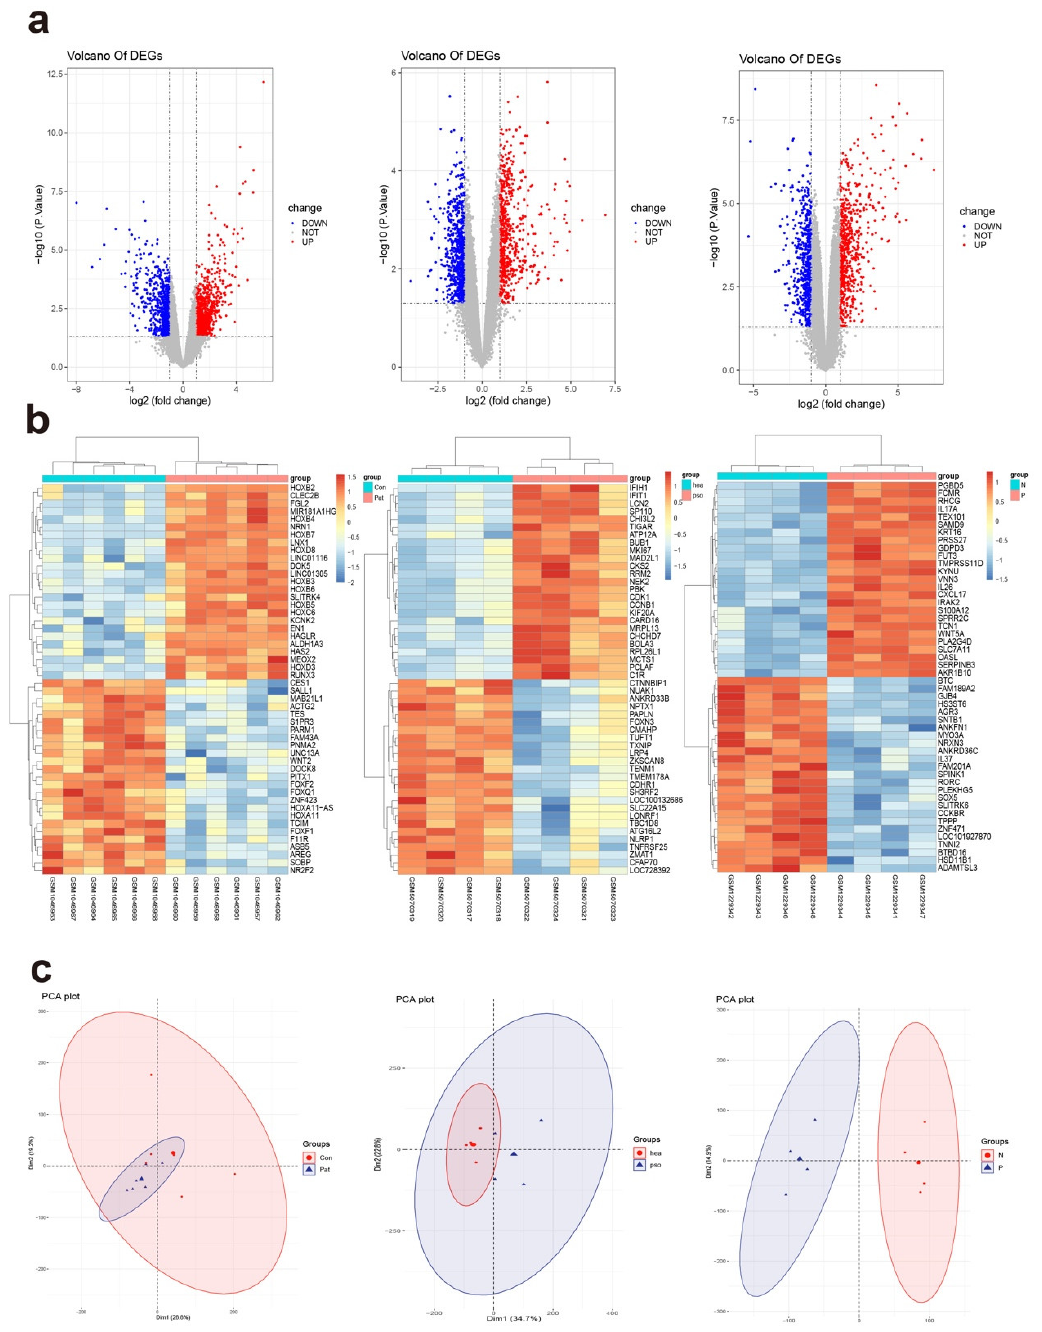
Figure 1. ( a ) Volcano plot representing DEGs among normal control group, PN and PP. The X -axis indicates the adjusted p (log-scaled) and the Y -axis shows the fold change (log-scaled). Each dot stands for a separate gene; red dots represent genes that have been upregulated, gray spots represent genes that have had little to no change in expression, and blue dots represent genes that have been downregulated based on adjusted p < 0.05 and |log2 FC| > 1. ( b ) The DEGs’ heat map. The sample numbers are located in the abscissa, while the gene names are in the ordinate. DEGs that are upregulated are indicated by red, while those that are downregulated by blue. ( c ) PCA among normal control group, PN and PN. The smaller the overlap of two circles, the more different of two groups.